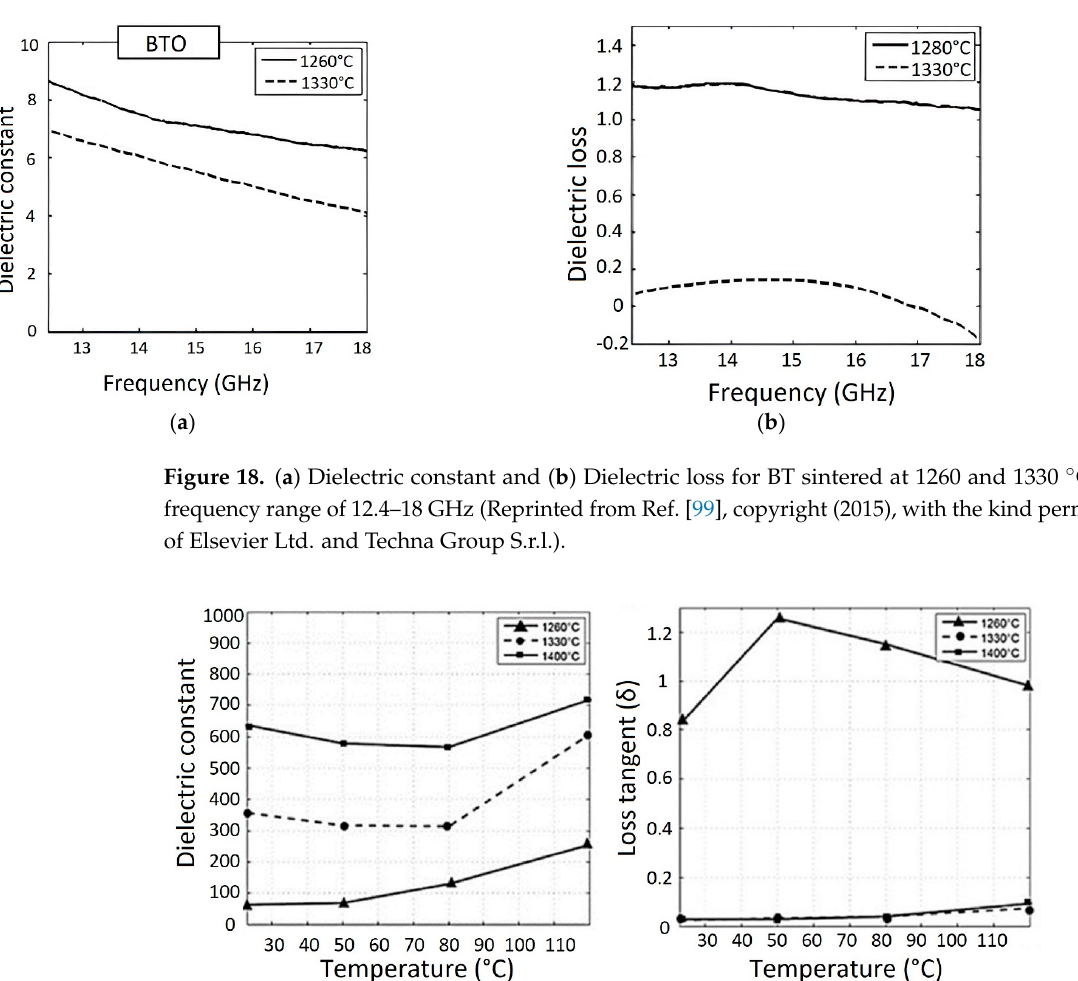
Figure 19. ( a ) Dielectric constant and ( b ) Dielectric loss for BT sintered at 1260, 1330, and 1400 °C at 1 kHz frequency (Reprinted from Ref. [99], copyright (2015), with the kind permission of Elsevier Ltd. and Techna Group S.r.l.).